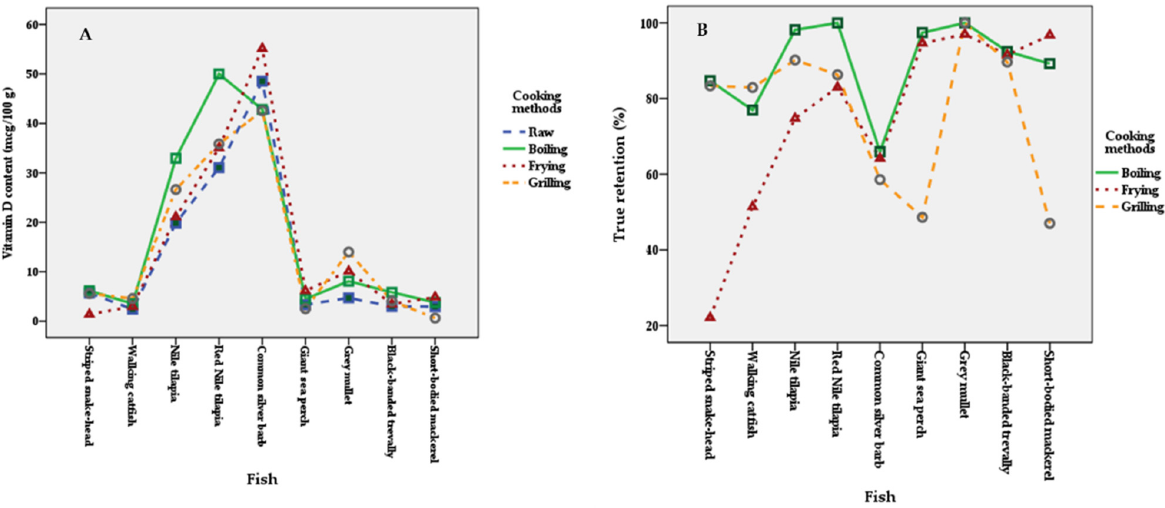
Figure 1. The combined effects of different kinds of fish and cooking methods on vitamin D content ( A ) and on the percentage of true retention ( B ). Table 5. Estimated marginal means of vitamin D content and percentage of vitamin D true retention by the main effects of different species of fish and cooking methods (calculated from two-way ANOVA) ( n = 3).